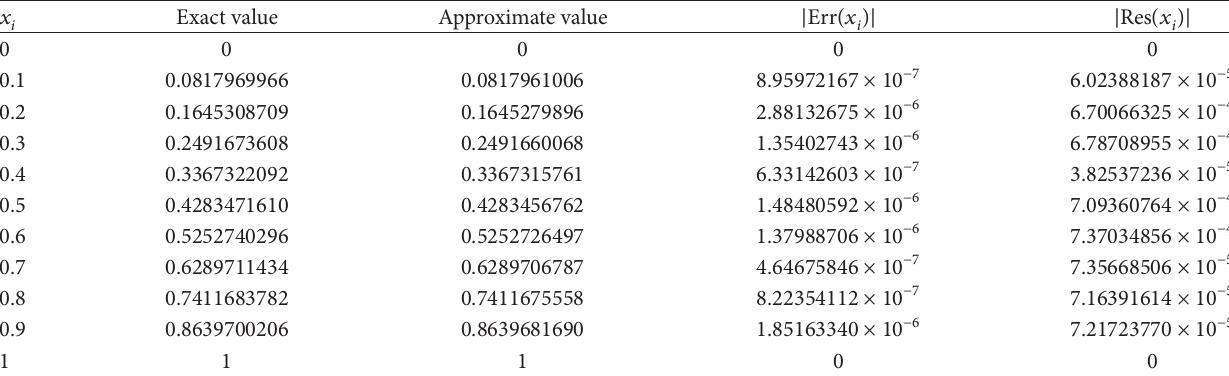
Table 2: Numerical results for Troesch’s problem when 𝜆 = 1